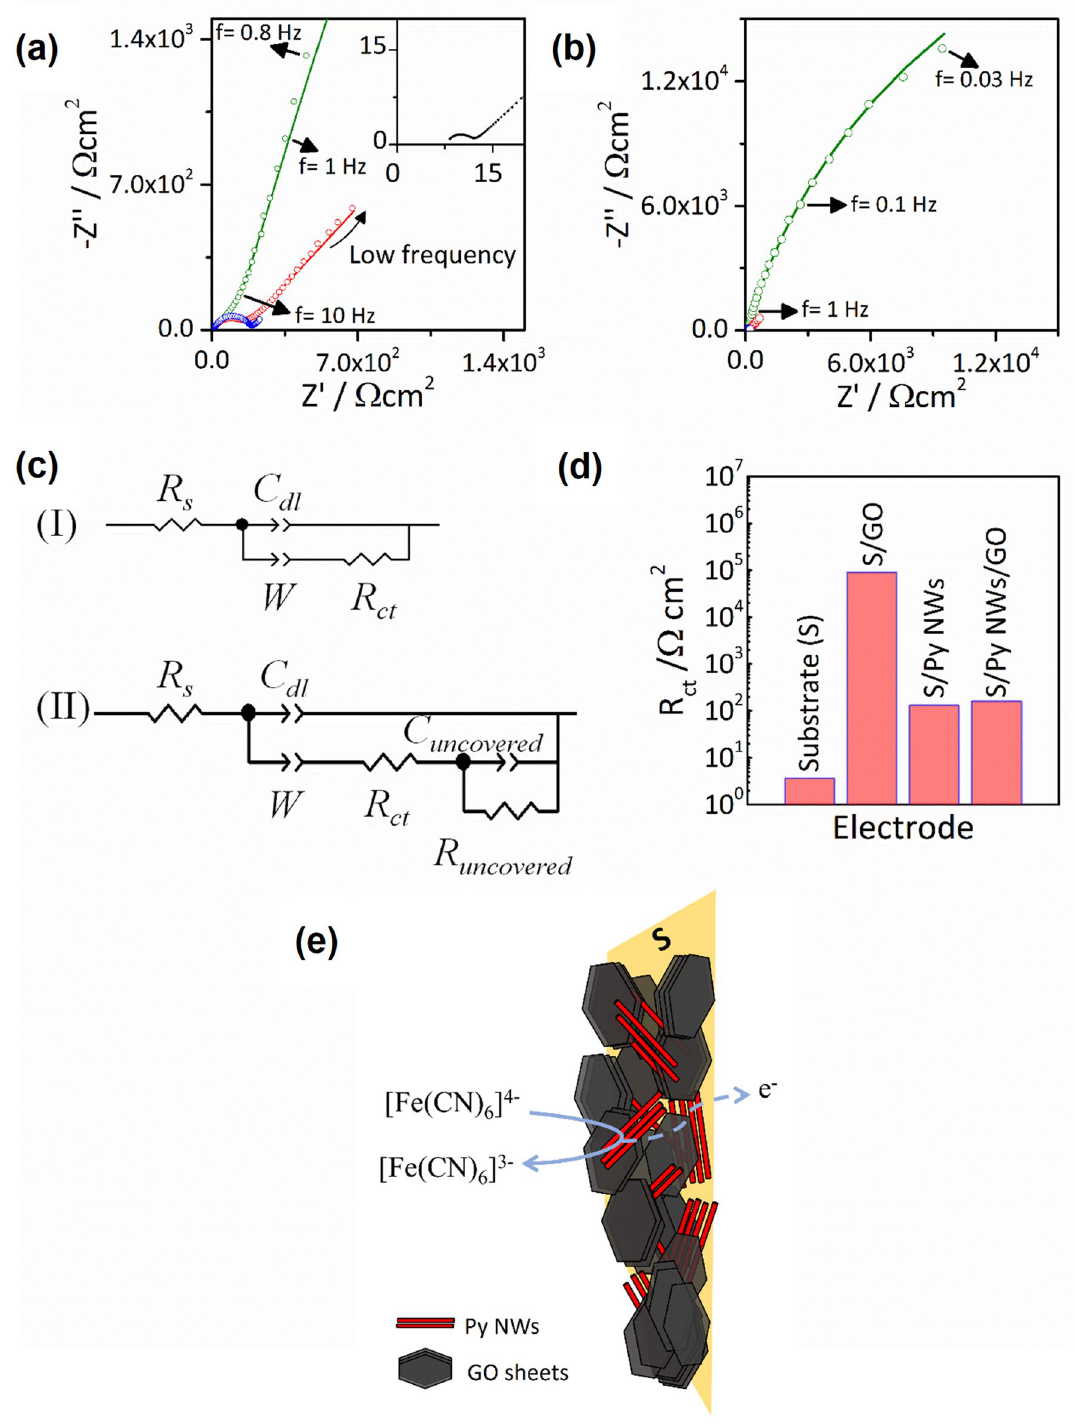
Figure 8. ( a ) and ( b ) Nyquist diagrams in 10 mM [Fe(CN) 6 ] 3− /[Fe(CN) 6 ] 4− solution of experimental (open circles) and fitting data (lines) of GO (Green), Py NWs/GO (red) and Py NWs (blue). Inset in ( a ): Substrate (black). ( a ) and ( b ) show the same data in different frequency domain. ( c ) Circuits used for fitting. ( d ) Charge- transfer resistance of the different electrodes. ( e ) Proposed